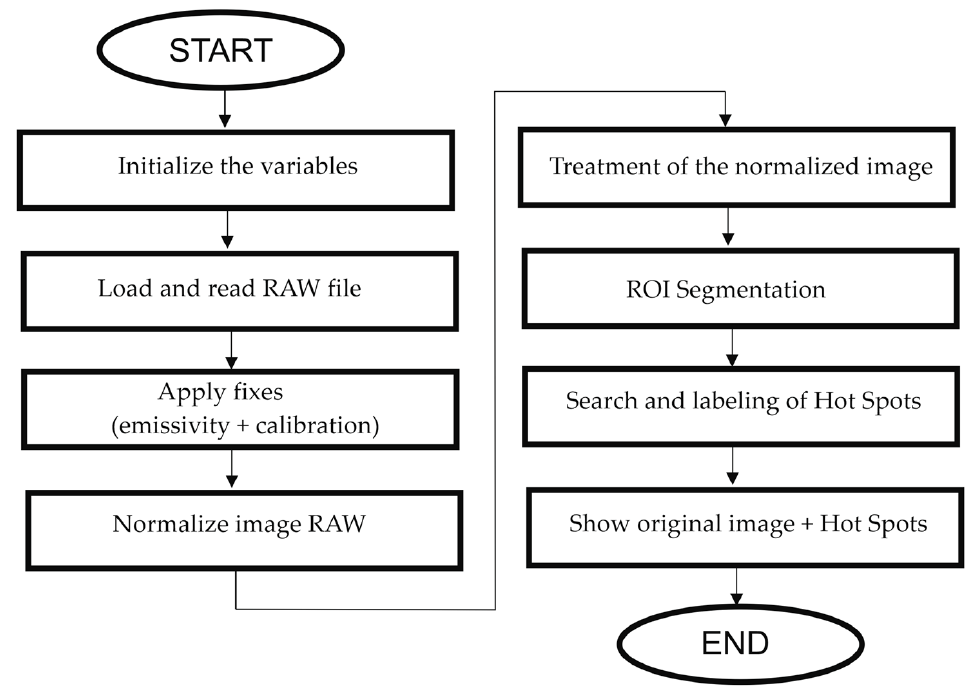
Figure 12. Global execution flux diagram of the hot-spot search and labelling algorithm.